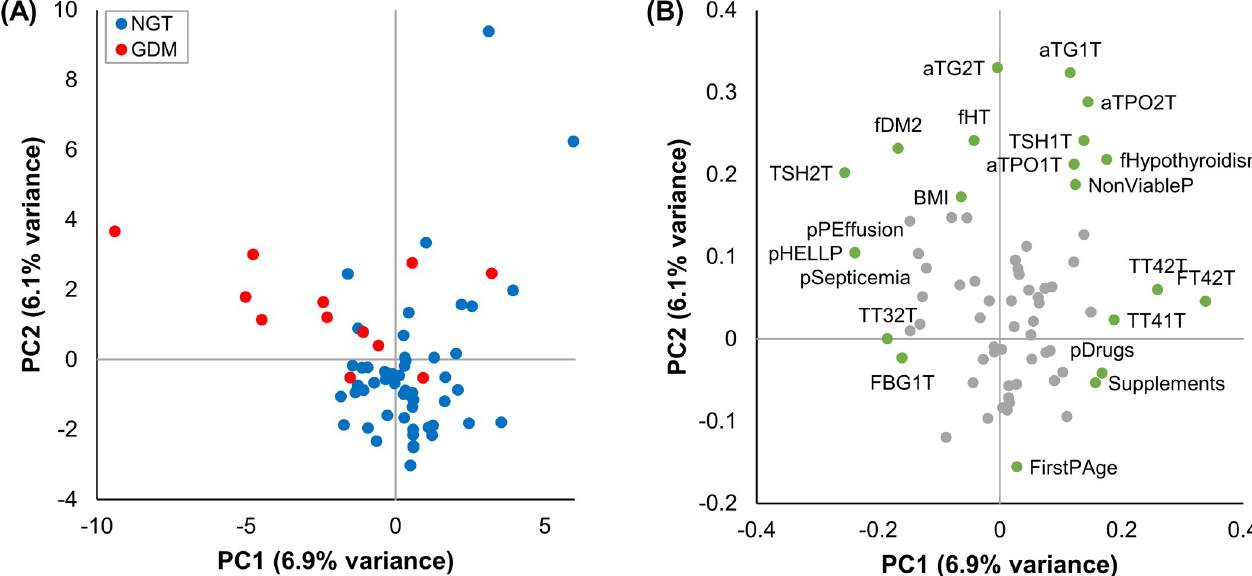
Fig 1. Exploration of maternal data by principal component analysis. (A) The scores plot shows the NGT (blue) and GDM (red) subjects projected in the space constituted by PC1 and PC2. (B) The loadings plot shows the variables contribution to PC1 and PC2. The ones that contribute the most to each PC are highlighted (green) and labeled. NGT : Normal glucose tolerance . GDM : Gestational diabetes mellitus . PC : Principal component . 1T : First trimester . 2T : Second trimester . pHELLP : Prior hemolysis elevated liver enzymes and low platelets syndrome . pPEffusion : Prior pleural effusion . pSepticemia : Prior septicemia . fDM2 : Family history of type 2 diabetes . fHT : Family history of hypertension . BMI : Body mass index . fHypothyroidism : Family history of hypothyroidism . NonViableP : Prior non-viable pregnancy . pDrugs : Drug use before pregnancy . Supplements : Supplement consumption . FirstPAge : First period age . TSH : Thyroid stimulating hormone . aTG : Thyroglobulin antibody . aTPO : Thyroid peroxidase antibody . TT4 : Total thyroxine . FT4 : Free thyroxine . TT3 : Total triiodothyronine . FBG : Fasting blood glucose .